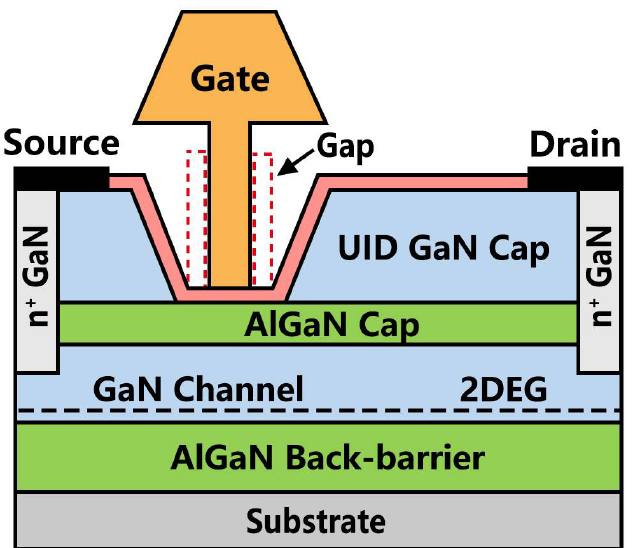
Figure 12. Schematic diagram of the gap between the gate metal and the GaN cap sidewalls.